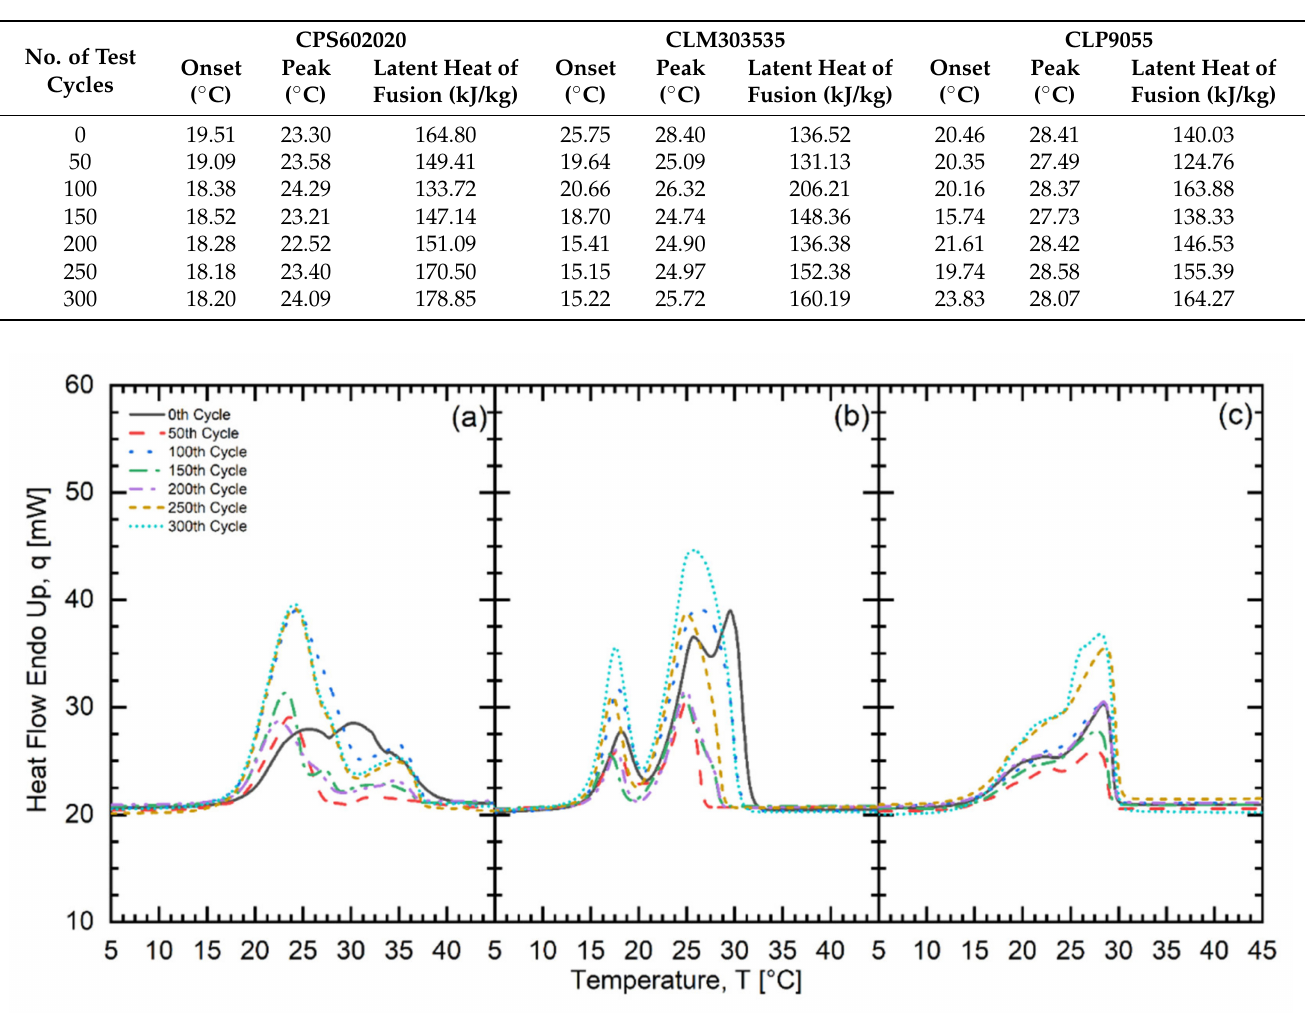
Table 10. Latent heat of fusion and melting temperature of developed materials with test cycles (CPS602020, CLM303535, CLP9055).